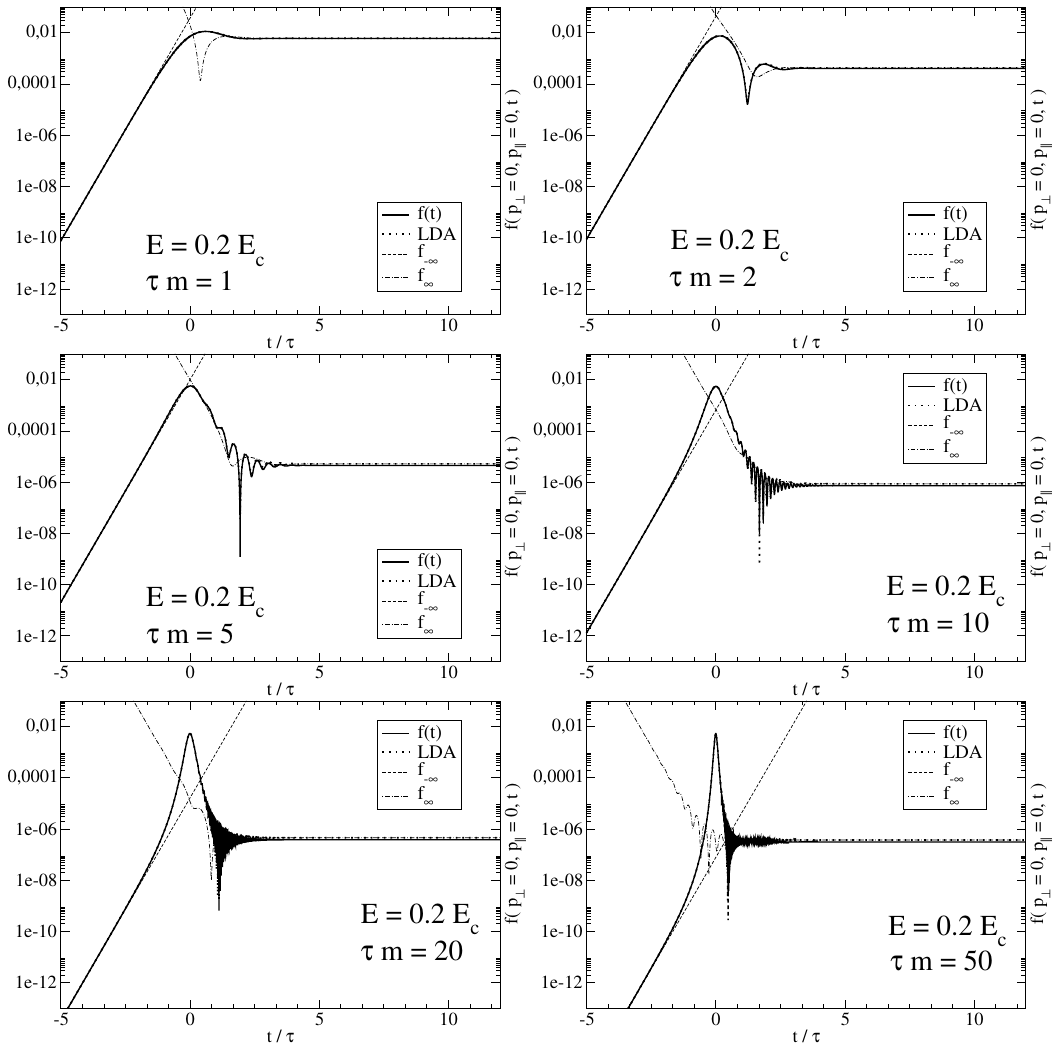
Figure 3. Time evolution of the fermionic distribution function as in Figure 2, but for E 0 = 0.2 E c